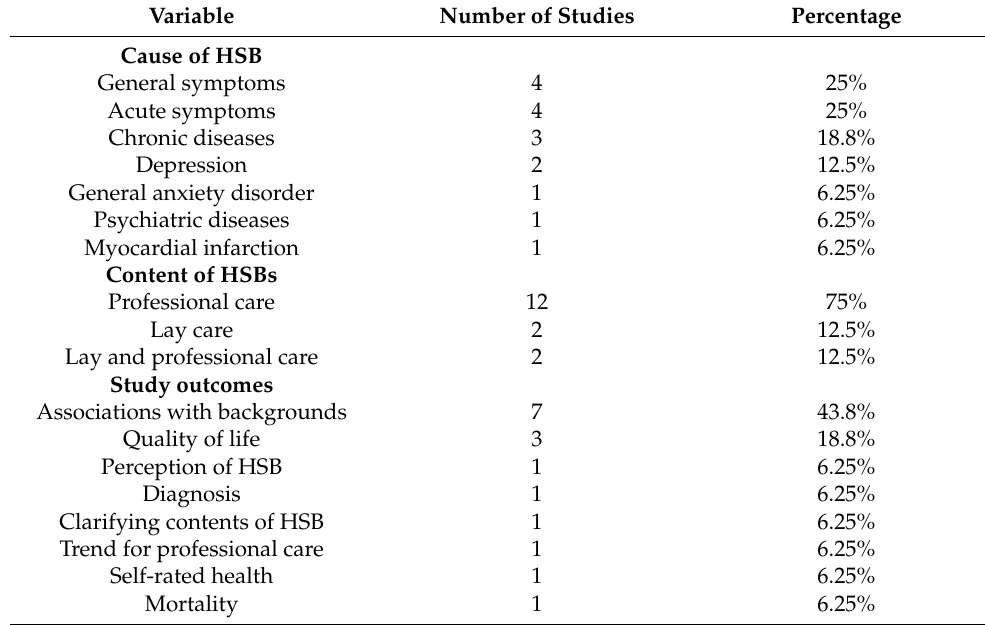
Table 4. The causes of HSBs, the contents of HSBs, and the study’s